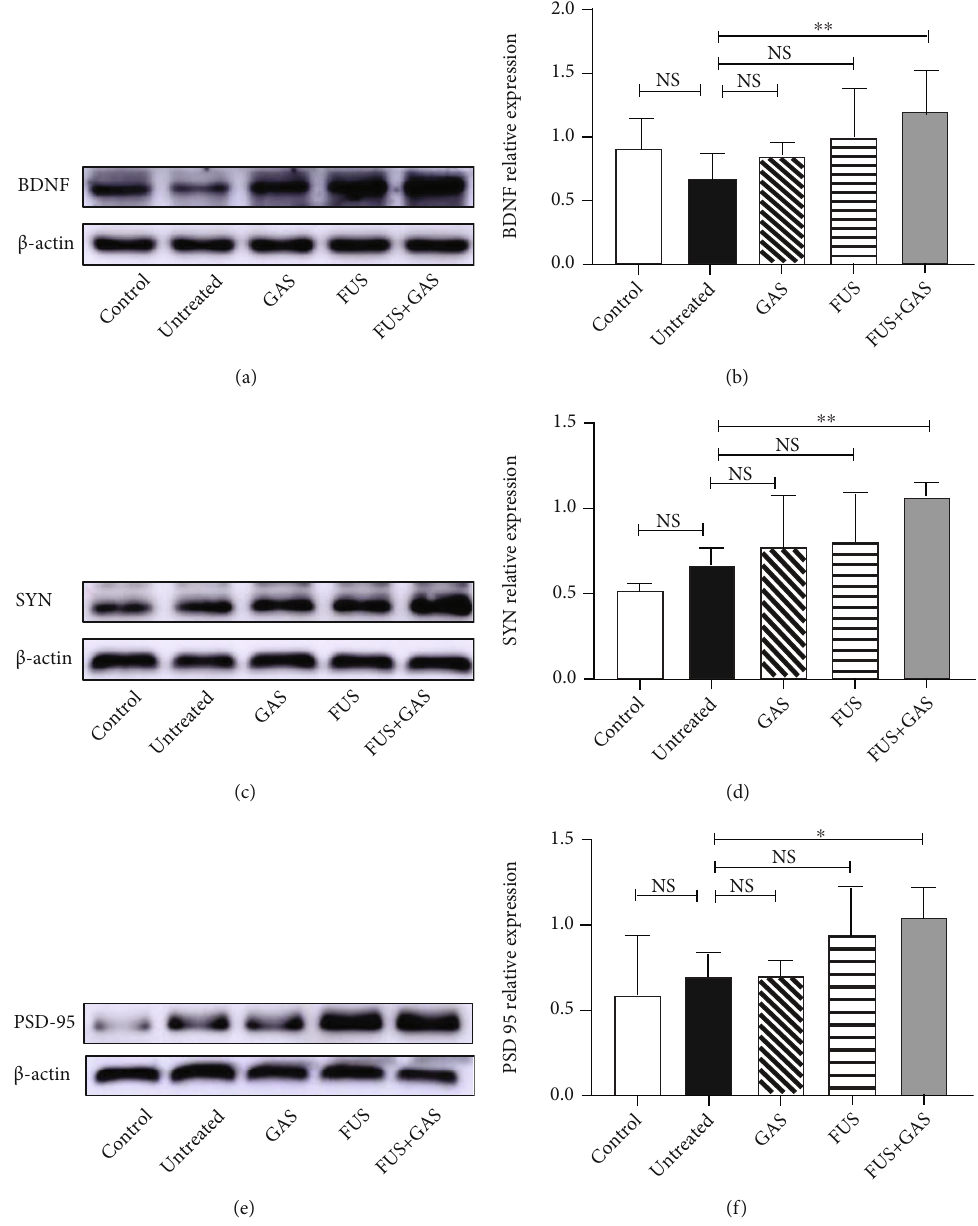
Figure 10: Relative concentrations of BDNF (a, b), SYN (c, d), and PSD-95 (e, f) in the sonicated hippocampus of all groups. Combined treatment (GAS+FUS) statistically upregulated the level of BDNF, SYN, and PSD-95 while single treatment (GAS/FUS alone) failed to. Each symbol represents the mean ± SD ; ∗∗ P < 0 : 01 against untreated mice; ∗ P < 0 : 05 against untreated mice. One-way ANOVA; n = 5 per